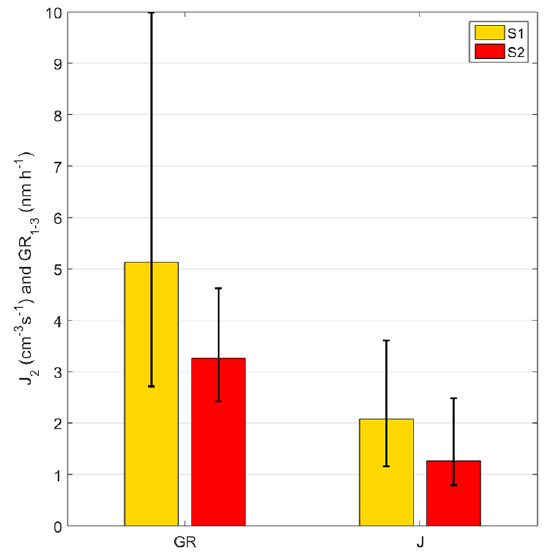
Figure 7. Median formation rate of 2nm particles ( J 2 ) and growth rate in the range 1–3nm (GR 1–3 ) reported separately for type I events initiated in the BL (scenario S1) and in the FT (scenario S2). Lower and upper limits of the error bars stand for the 1st and 3rd quartiles,